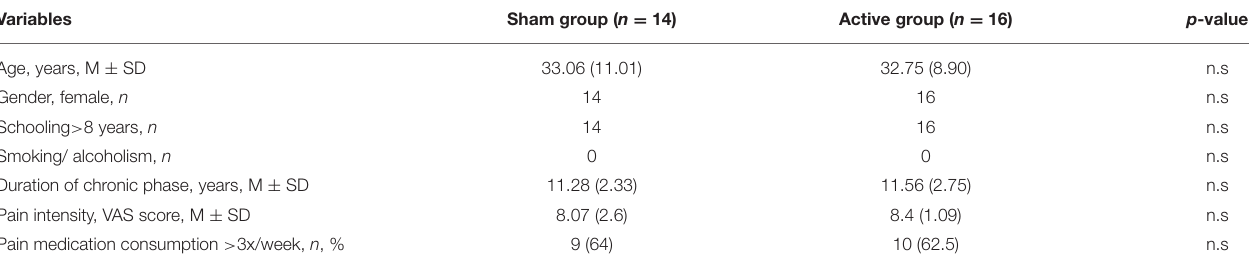
TABLE 1 | Demographic and clinical characteristics of the participants at